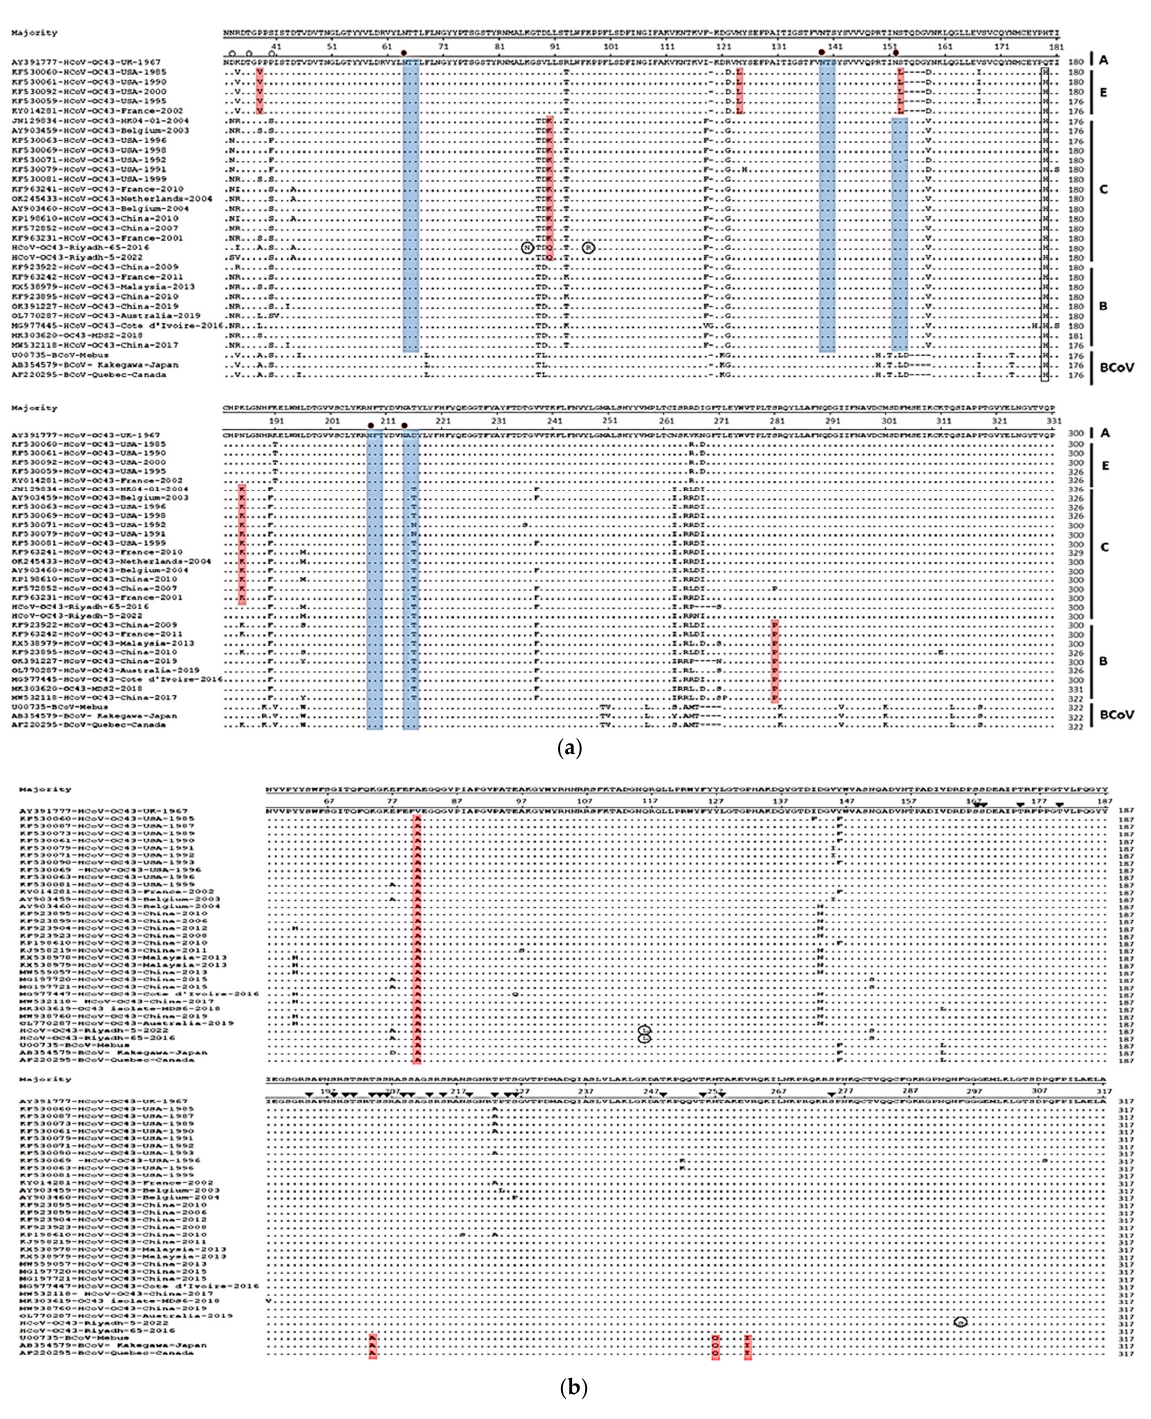
Figure 1. Deduced amino acid alignments of the glomerular ( a ) S gene and ( b ) N gene. Strains that represent the four genotypes were selected, and the alignment was performed by Clustal W (Meg ‐ Align program, DNAstar). The strain HCoV ‐ OC43 (accession number: AY391777) isolated during the year 1967 was set as the consensus sequence. Genotype ‐ specific amino acids are highlighted in red. Predicted N ‐ glycosylation sites are highlighted in blue and O ‐ glycosylation sites are indicated by small filled triangles.